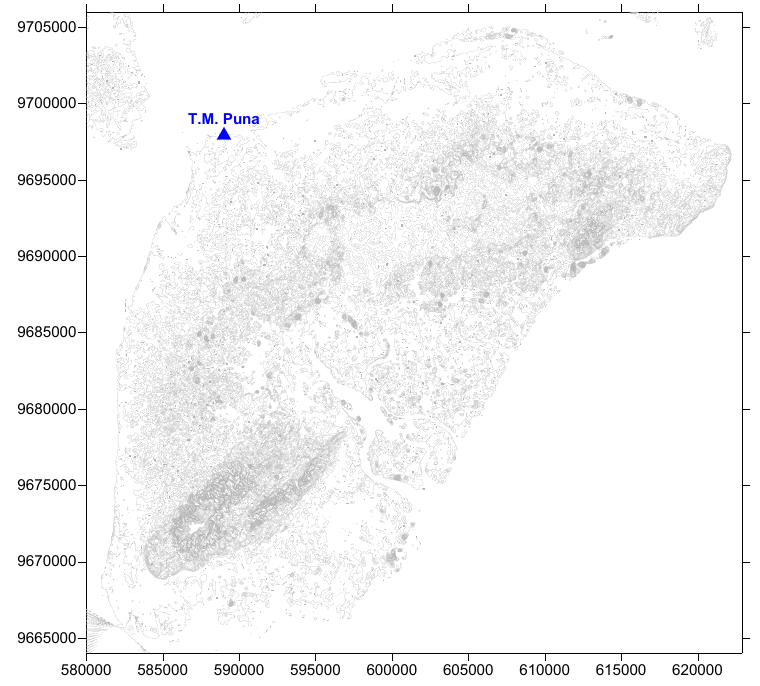
Figure 16. Contour lines every 5 m.